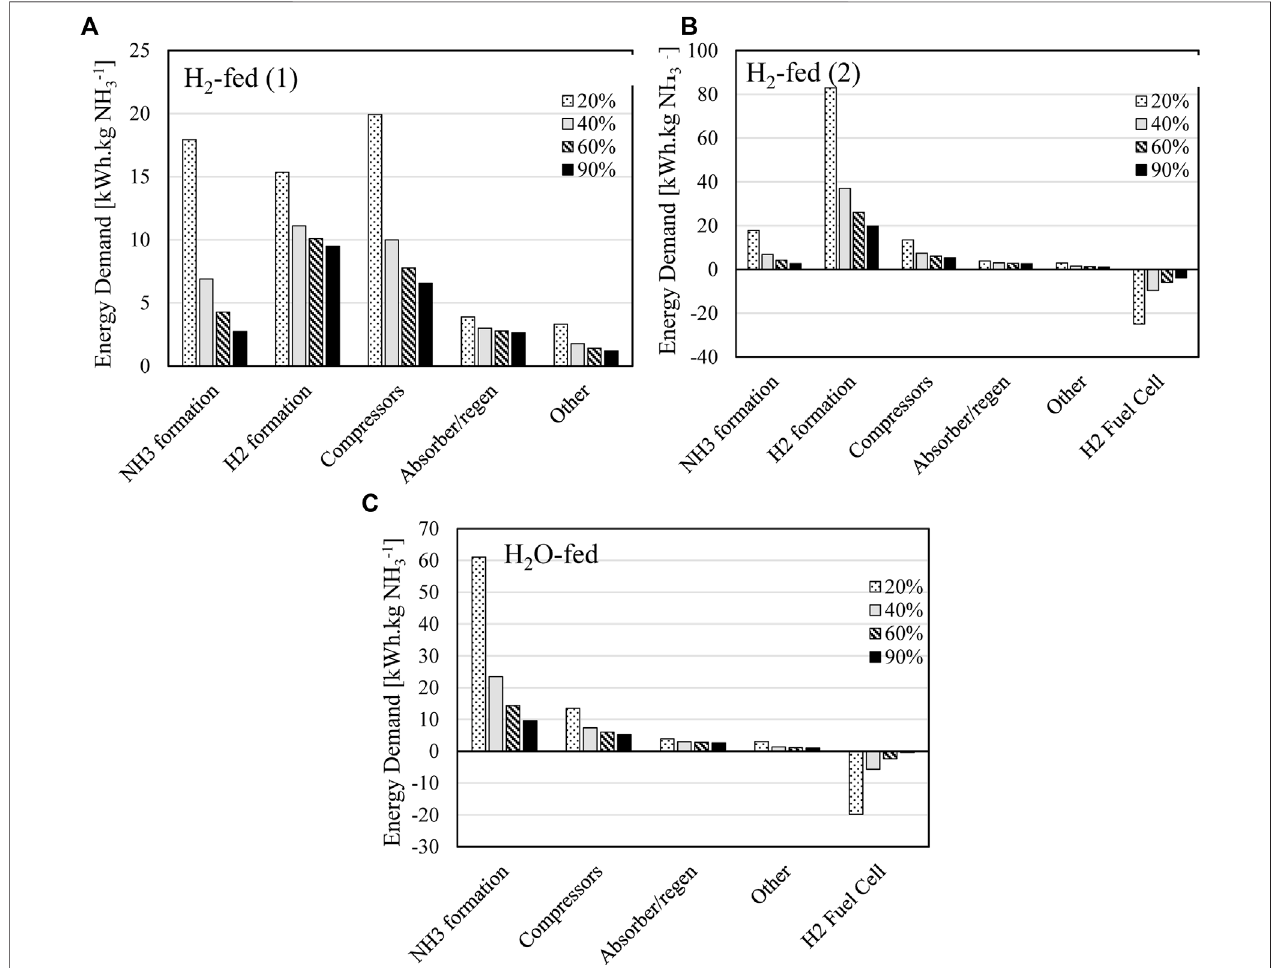
FIGURE 8 | Energy demand breakdown of different plant components for (A) H 2 -fed (1), (B) H 2 -fed (2), and (C) H 2 O-fed.